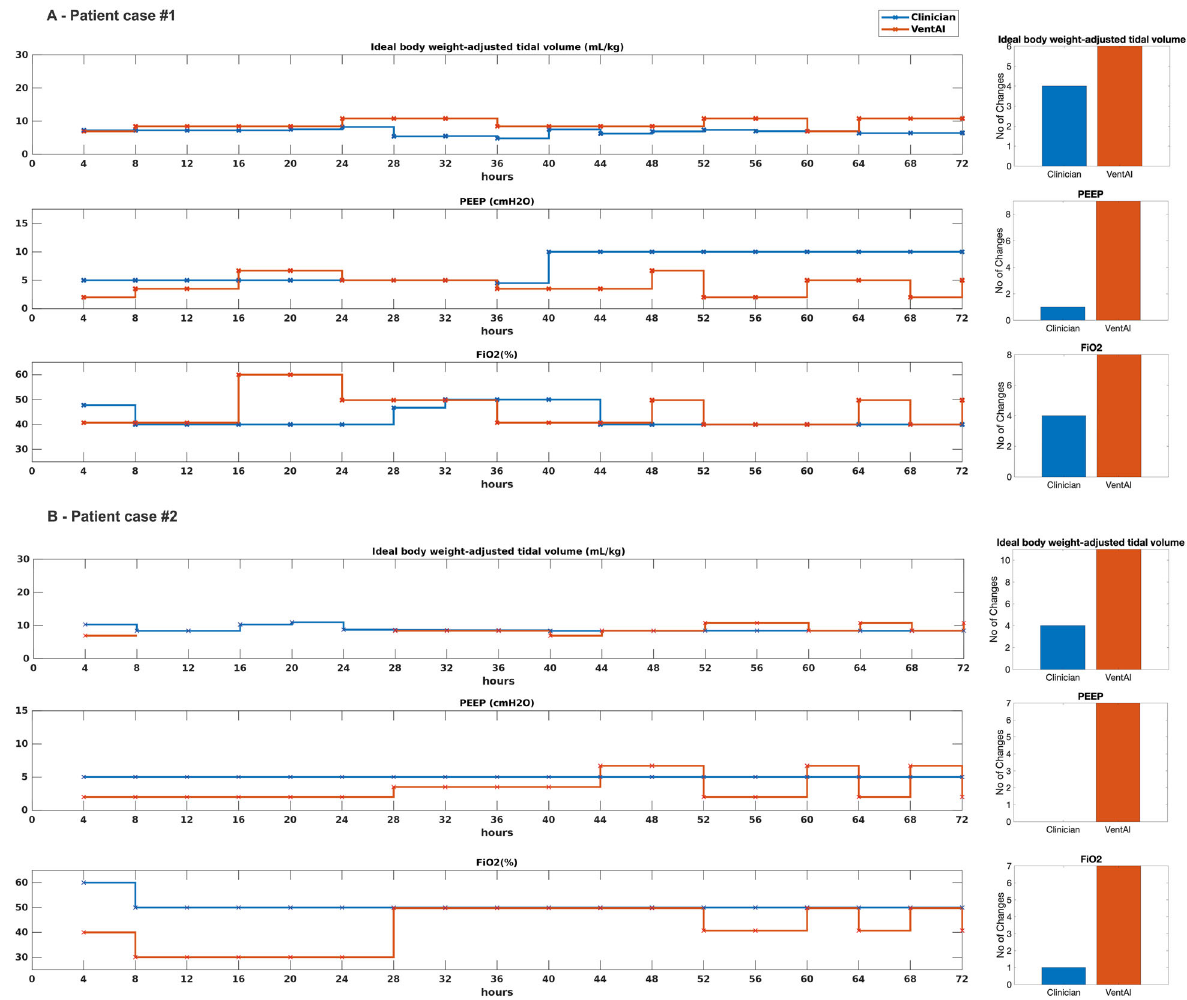
Fig. 5 Visualization of two representative patient cases (MIMIC-III dataset). Visualization of two representative case studies in 4-hour intervals. Both patients died within the observed 90 days. Clinicians ’ actions are shown in blue while the VentAI actions are shown in